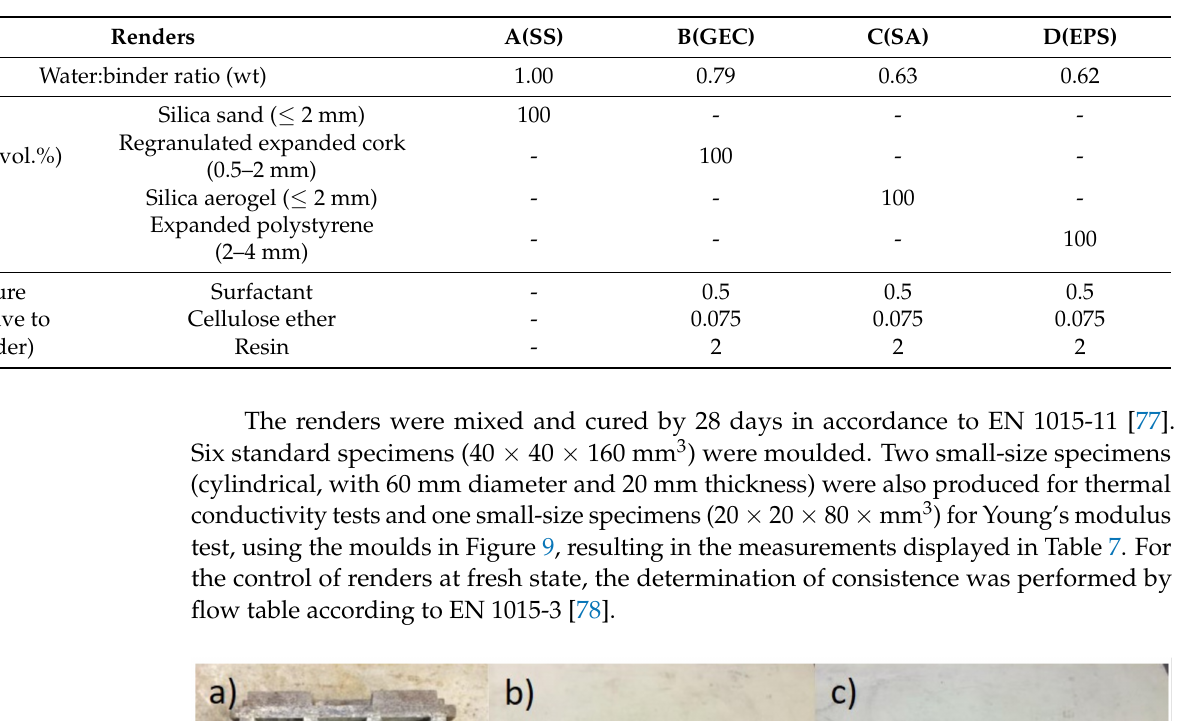
Table 6. Identification of the render samples according to lightweight aggregates.